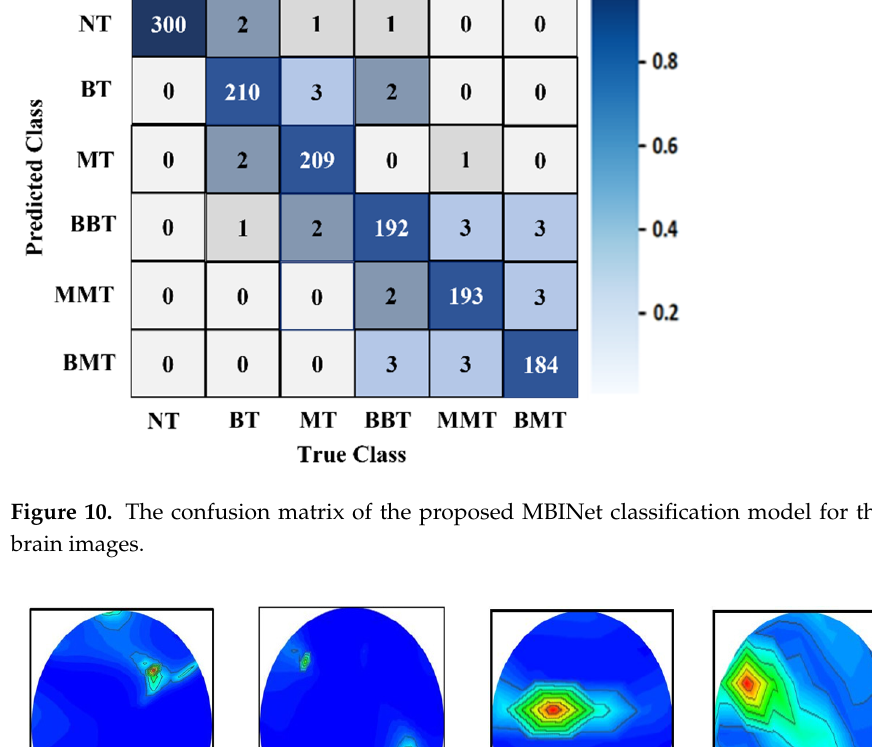
20 of 25 Figure 9. Receiver Operating Characteristics (ROC) curve with AUC. 4.3. Performance Analysis It was determined from the classification performances in Tables 4 and 5 that the best classification model was MBINet for classifying the RMB images. The overall classification